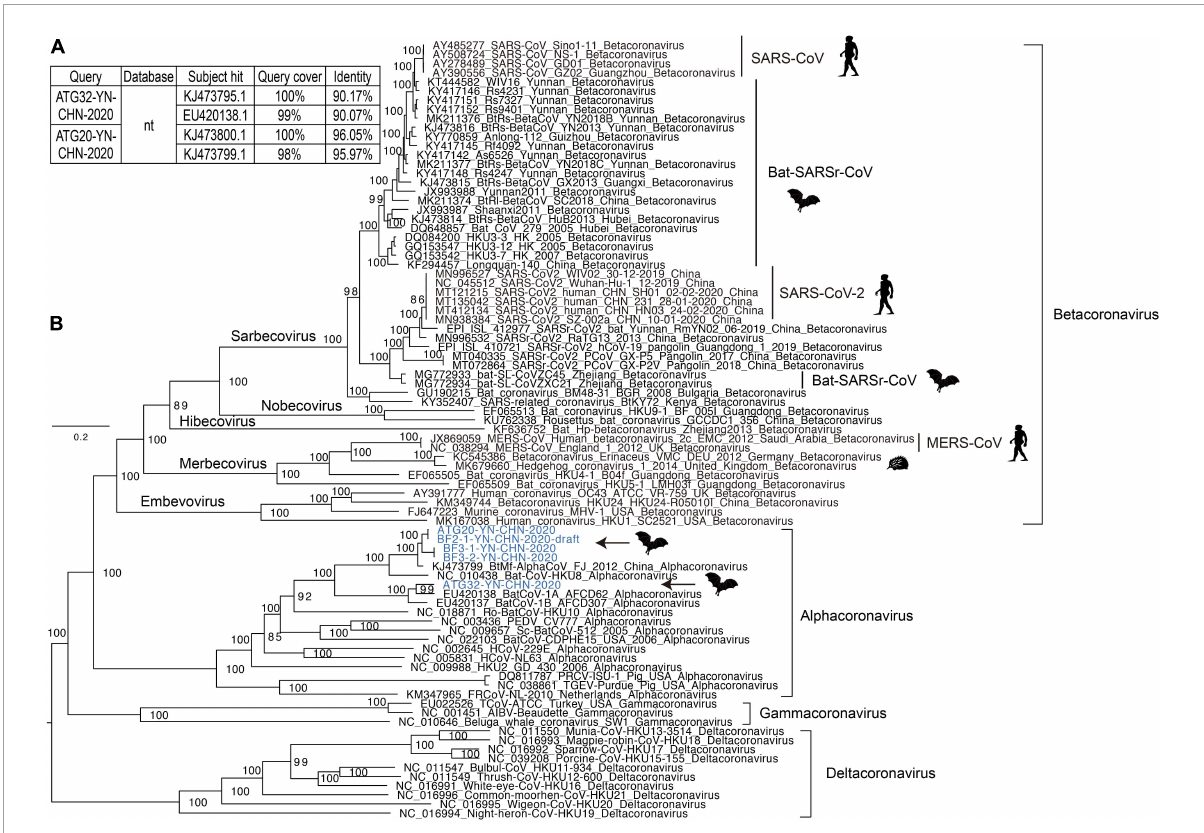
FIGURE3 Analysis of coronavirus genomes. (A) The top two hits obtained using BLASTN for two representative coronavirus strains. (B) Maximum likelihood tree of representative genomes of coronaviruses, including alphacoronaviruses, betacoronaviruses, gammacoronaviruses, and deltacoronaviruses. The new strains identified in this study are shown in blue. The scale bars show the substitutions per site per year. The values at each node indicate the bootstrap and SH-like approximate likelihood ratio test (SH-aLRT) values, with 1,000 bootstrap